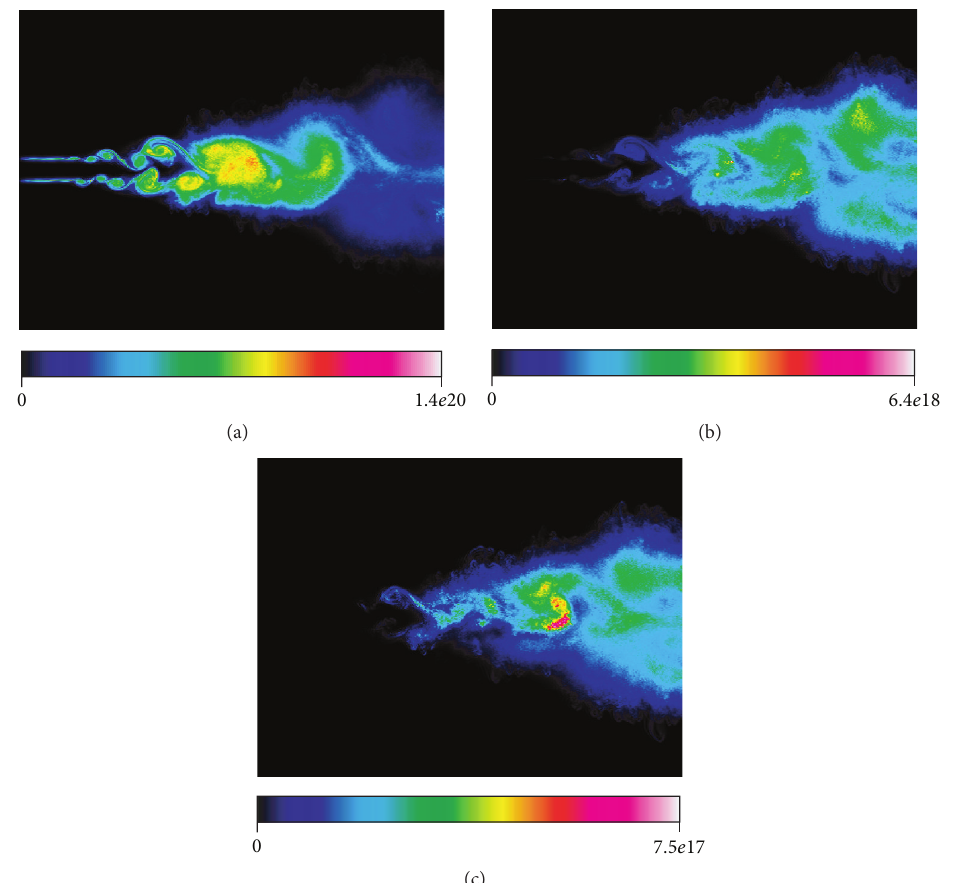
Figure 3: Instantaneous contours of the 𝑧 -direction averaged particle number concentrations: (a) monomers; (b) 1nm; (c) 2 nm.